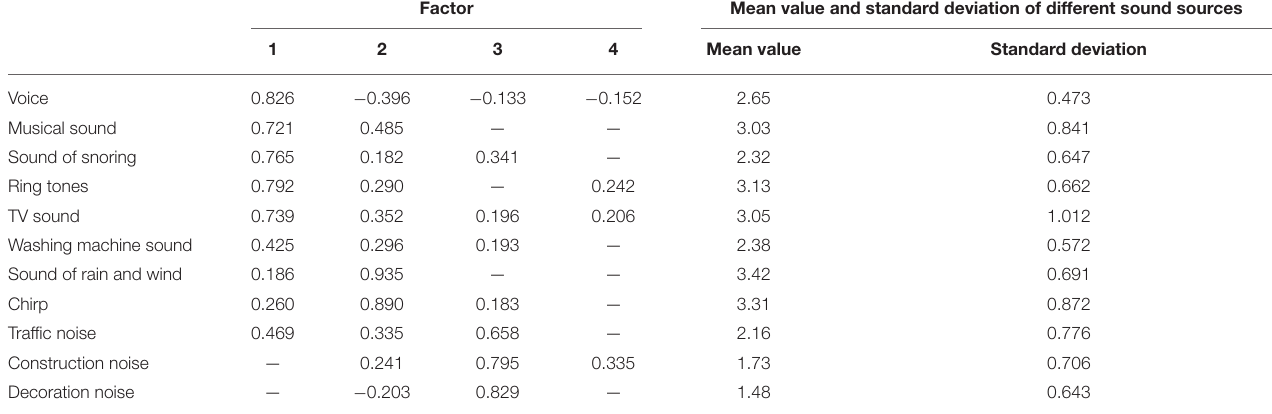
TABLE 9 | Total variance explained by factor